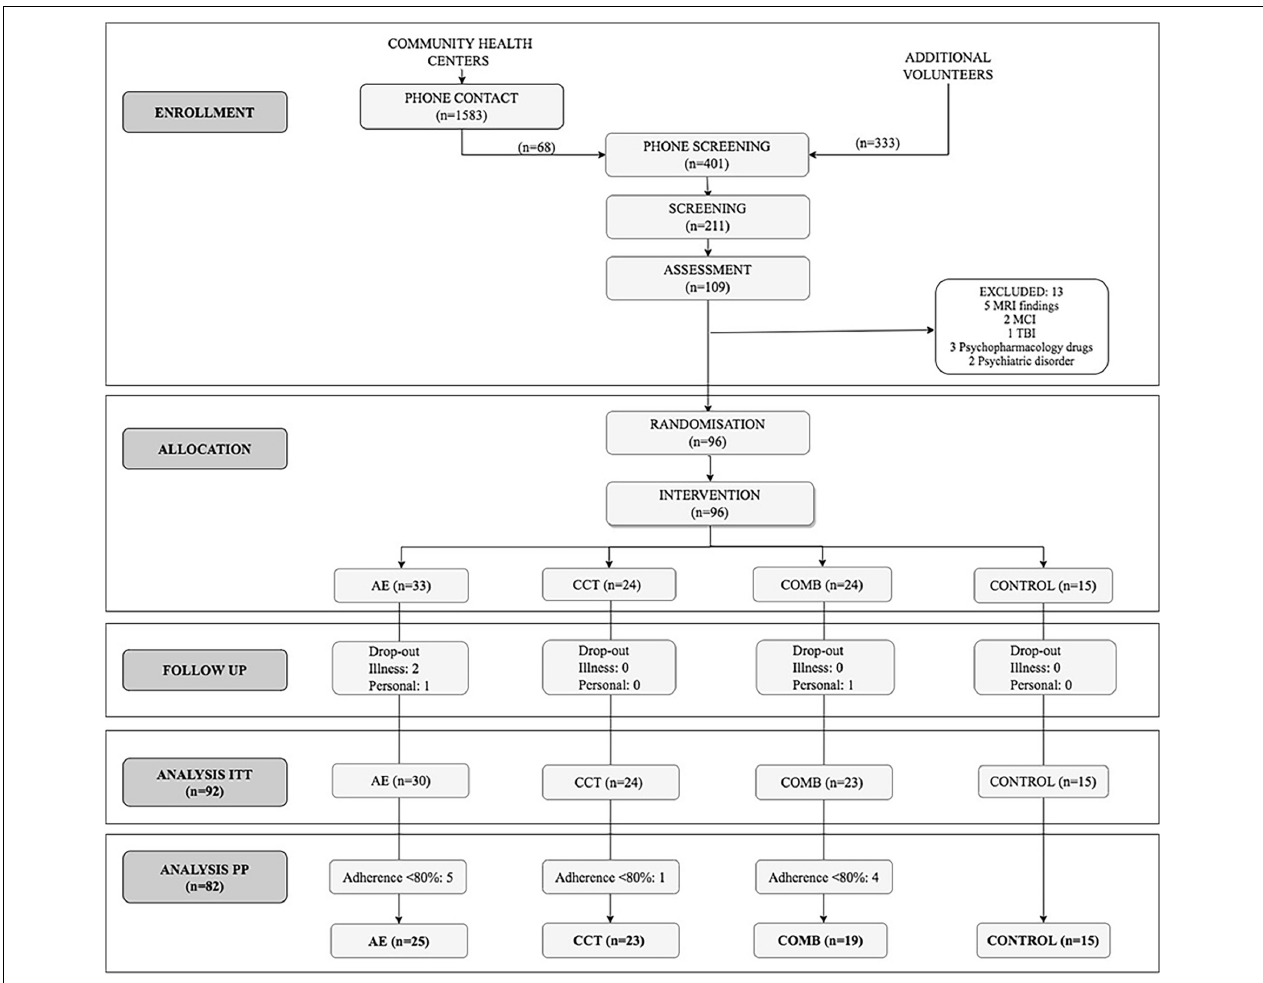
FIGURE 1 | CONSORT flow